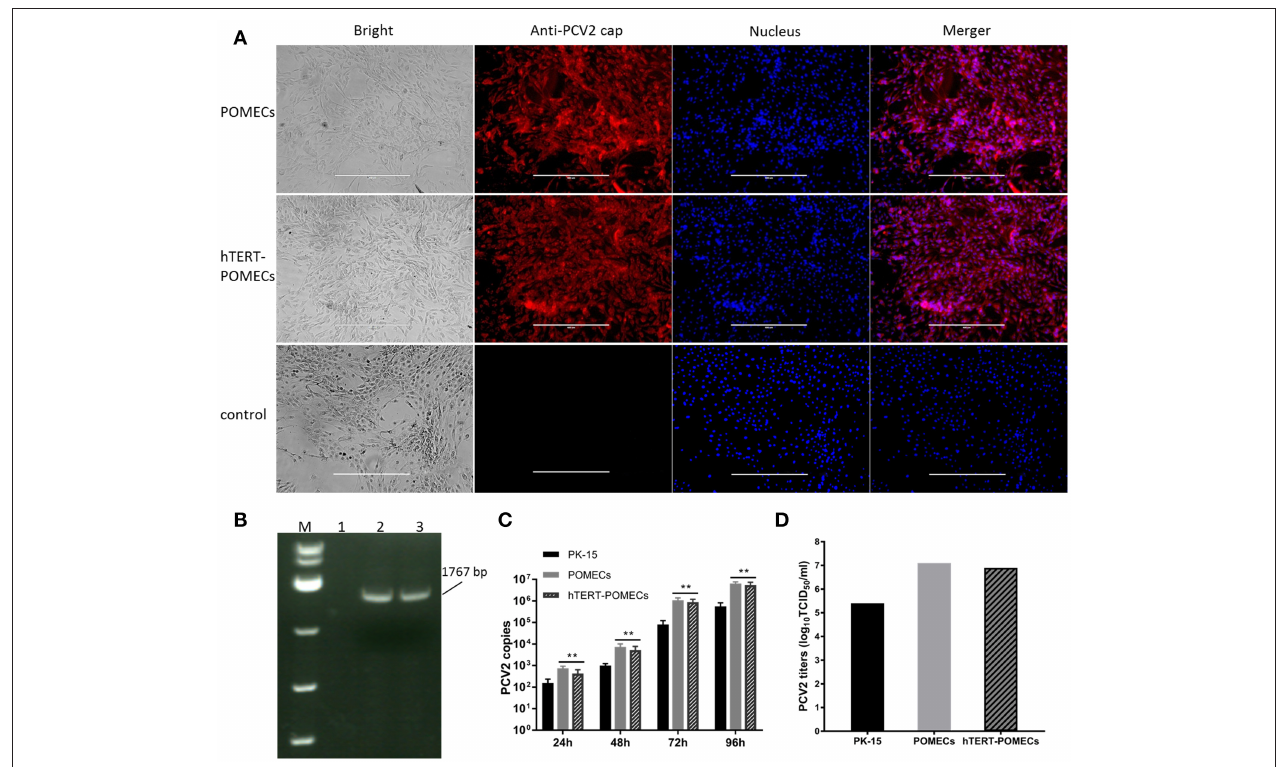
FIGURE 5 | Infection of PCV2. (A) Detection of PCV2 by immunofluorescence. Third passage POMECs and 70th passage hTERT-POMECs were infected with PCV2 at a MOI of 1, and anti-PCV2 Cap protein antibodies was used to detect PCV2 at 24 hpi. Uninfected hTERT-POMECs served as negative control ( × 100 magnification, scale bar is 400 µ m). (B) Detection of PCV2 by RT-PCR. PCV2 intact genome was positively detected in the infected POMECs (line 2) and hTERT-POMECs (line 3), but not in uninfected hTERT-POMECs (line 1). M: DL 5000(Takara). (C) Analysis of PCV2 replication in PK-15, POMECs and hTERT-POMECs at 24, 48, 72, 96 hpi by real-time quantitative PCR. The data shown are representative of three independent experiments. ** P < 0.01 vs. PK-15 cells under the same condition. (D) Viral titers of PCV2 propagated in PK-15, POMECs and hTERT-POMECs at 96